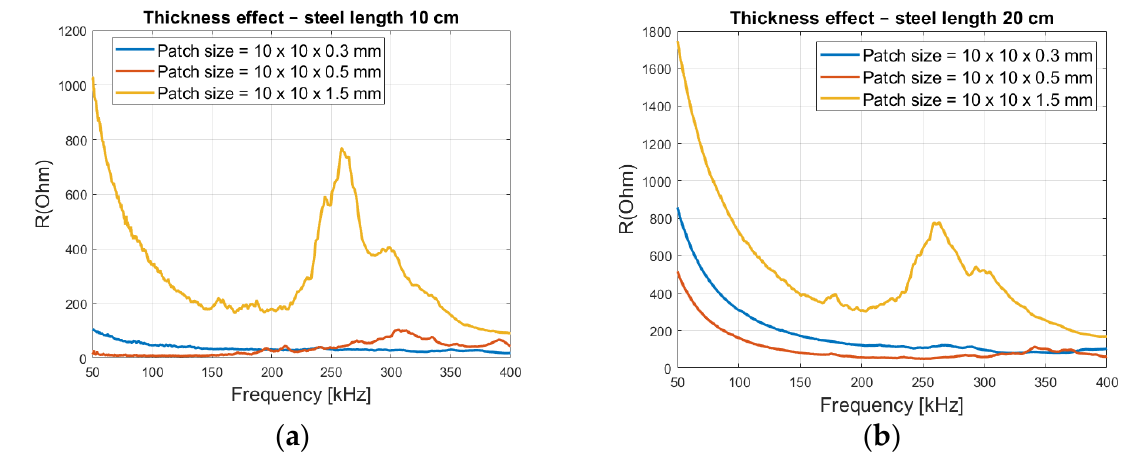
Figure 14. Real part of the impedance with varying patch thickness ( a ) 10 cm and ( b ) 20 cm steel rod.